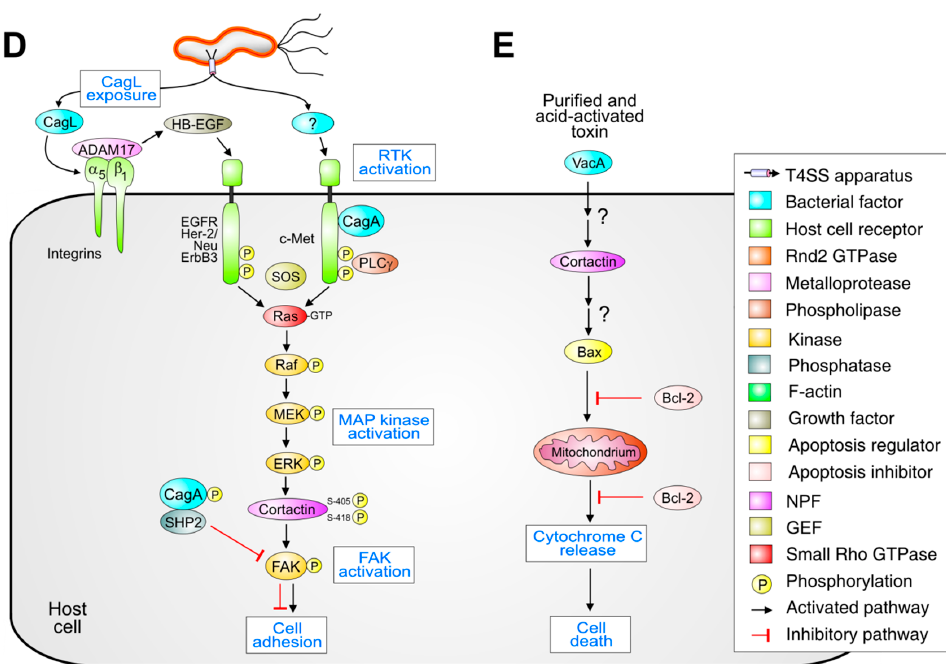
Figure 2. Schematic overview of molecular H. pylori signaling pathways that involve cortactin during infection of gastric epithelial cells. ( A ) The H. pylori T4SS pilus protein CagL activates c-Src tyrosine kinase through α 5 β 1 -integrin interaction [90]. Activated c-Src phosphorylates injected CagA, which in turn leads to the activation of Csk, a c-Src inhibitor [24,85]. Csk in complex with pragmin, a protein